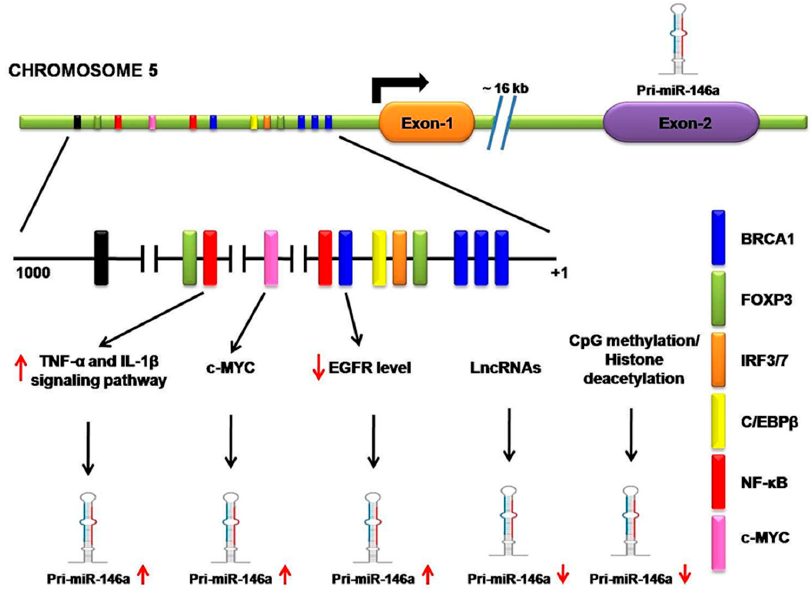
Figure 2. Transcriptional and posttranscriptional regulation of miR-146a. A regulatory sequence is located 16 kb upstream from the miR-146a gene. It contains a site for several transcription activator or repressor factors, such as breast cancer 1(BRAC1), forkhead box protein P3 (FOXP3), interferon regulatory transcription factor (IFR3/7), CCAAT enhancer-binding proteins β (C/EBP β ), nuclear factor kappa-B (NF- κ B), and c-MYC. NF- κ B regulatory inflammatory signaling pathways strongly upregulate miR-146a. c-MYC also increases miR-146a expression. BRCA1 directly binds the miR-146a promoter, increasing its expression, which in turn represses EGFR levels. Long non-coding RNA (lncRNA) directly interacts with miR- 146a and significantly interferes with its gene-silencing function. CpG methylation on the miR-146a regulatory sequence causes its